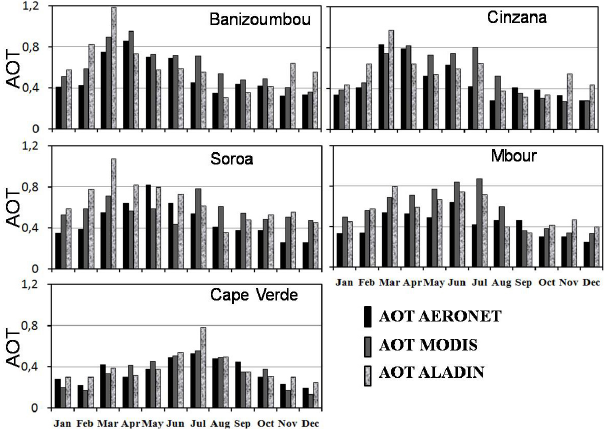
Figure 11. Monthly aerosol optical thickness observed by sun photometer (black) and MODIS (dark grey) and simulated by ALADIN (grey), averaged from 2006 to 2010 over